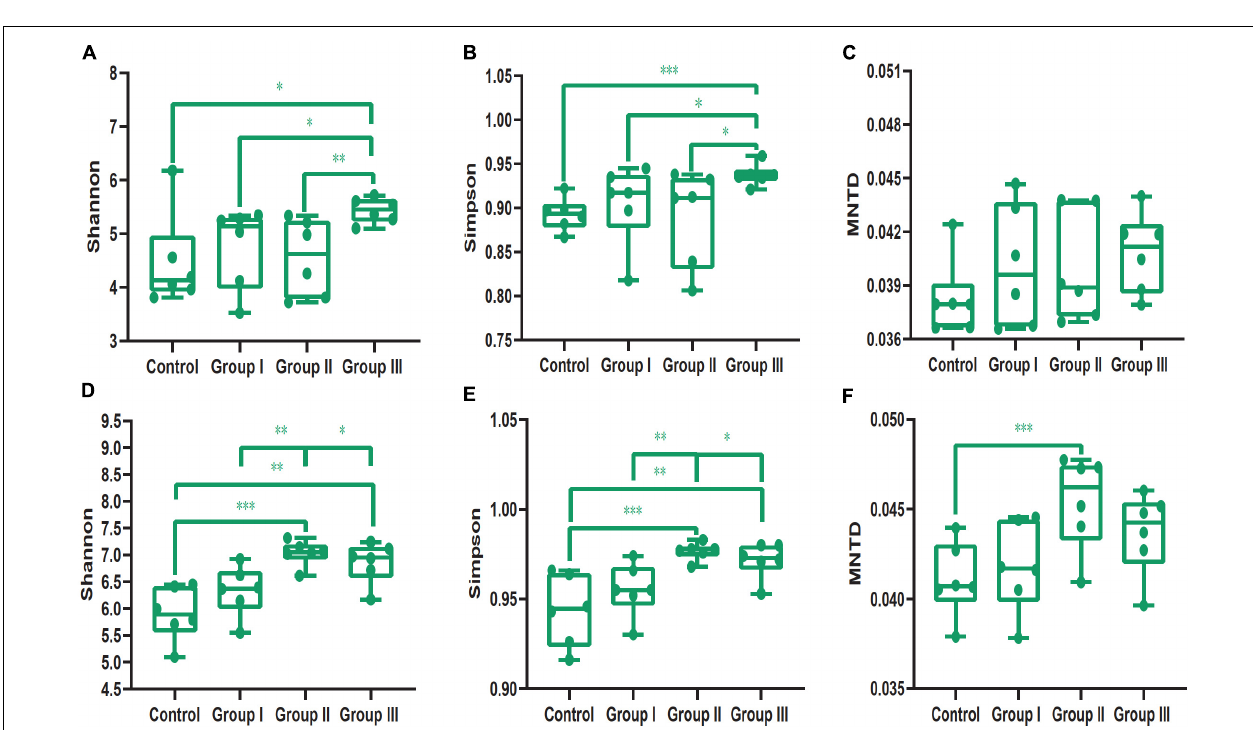
FIGURE 3 | The diversity index comparisons of the bacterial communities from jejunal and cecal content samples. The Shannon’s (A) , Simpson’s (B) and phylogenetic α -diversity (C) indices of the four dietary fiber groups from jejunal content samples. The Shannon’s (D) , Simpson’s (E) and phylogenetic α -diversity (F) indices of the four dietary fiber groups from cecal content samples. Differences were assessed by the Wilcoxon test and are denoted as following: * P < 0.05; ** P < 0.01; *** P < 0.001.